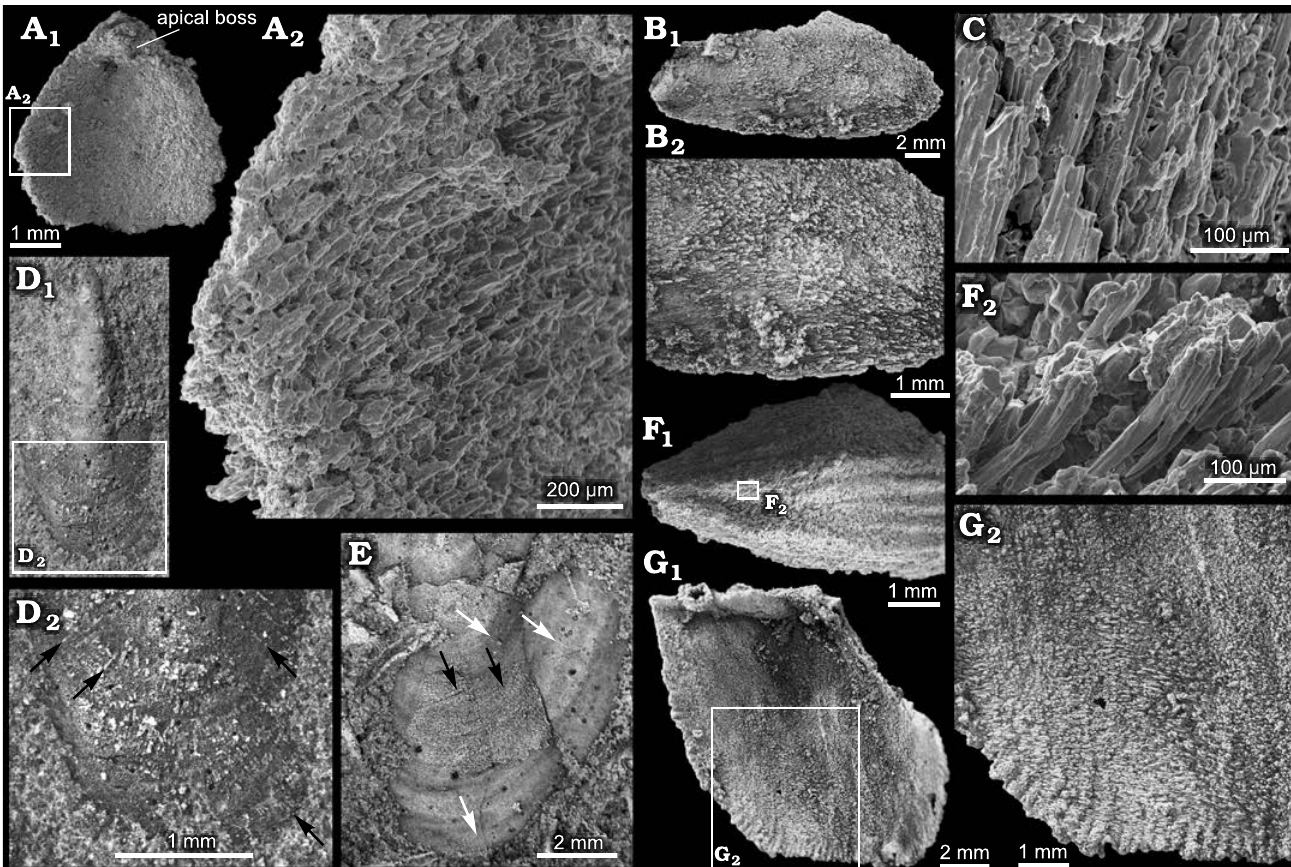
Fig. 12. Microstructure in the stenothecoid pan-brachiopod Stenothecoides spp. and co-occurring rhynchonelliformean brachiopods. A – C . Stenothecoides rasettii sp. nov., middle Cambrian, Burgess Shale Formation, Yoho National Park, Canada, Locality 1. A . TMP 2008.024.1142, fragmentary valve in interior view (A 1 ), detail showing silica rods imbricated and inclined toward valve margin (A 2 ). B . TMP 2008.024.1150, ventral valve in exterior view (B1), showing silica rods oriented with proximal ends of rods overlapping distal ends of preceding rods in posterior third of valve, but seemingly reversing orientation in posterior third of valve (B2). C . TMP 2008.024.1141 (same specimen and valve area as in Fig. 11C 1 , inner box) detail showing silica rods. D , E . Stenothecoides elongata (Walcott, 1884), Drumian Stage stratotype, Drum Mountains, western Utah (USA), Locality 8 (Robison 1964), external shell features. D . TMP 2021.022.0008, ventral(?) valve in exterior view (D 1 ), detail of anterior end (D 2 ), arrows show incompletely silicified radial rods. E . TMP 2021.022.0009, dorsal(?) valve, anterior end showing silicified outer shell surface with fine radial elements extending across growth varices (black arrows) and apparently shorter radial rods in valve sublayers (white arrows). F , G . Rhynchonelliformean brachiopods, silicified microstructure, Burgess Shale Formation, Canada, Locality 1. F . Tomteluva sp., TMP 2008.024.1151, silicified shell in exterior view (F1), posterior end is broken; anterior is to the right; detail showing orientation of silica rods (F 2 ), anterior is to the left. G . Fragmentary nisusiid, TMP 2008.024.1152, silicified shell in interior view (G 1 ), detail showing imbricated silica rods (G 2 ). A, C, F, SEM images and B, D, E, G, light microscope